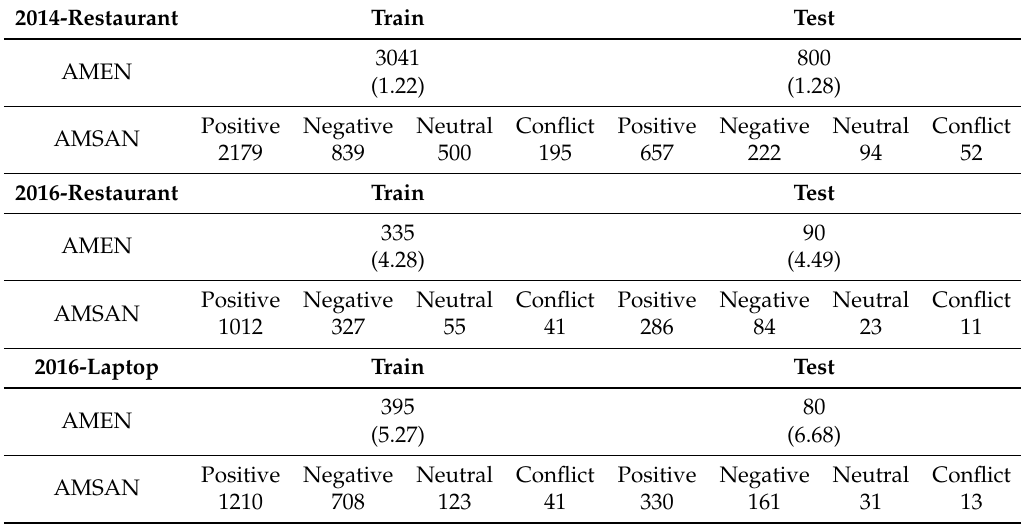
Table 1. Simple statistics on the number of instances in the datasets. Numbers in parentheses are average number of aspects per